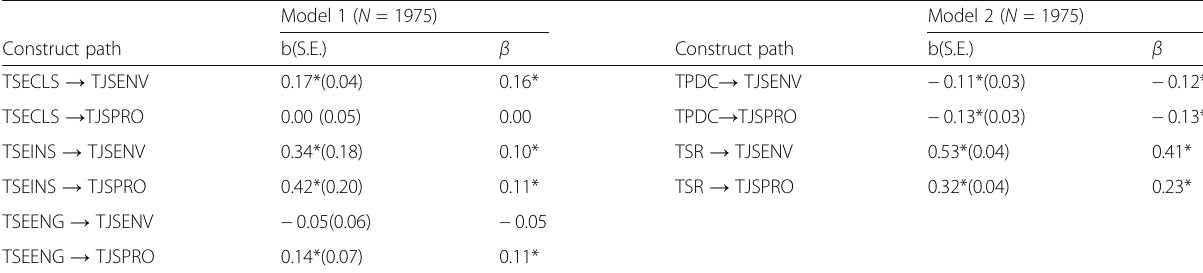
Table 2 Direct effects of each dimension of teacher self-efficacy and school climate variables on the two dimensions of job satisfaction Model 1 ( N = 1975) Model 2 ( N = 1975) Construct path b(S.E.) Construct